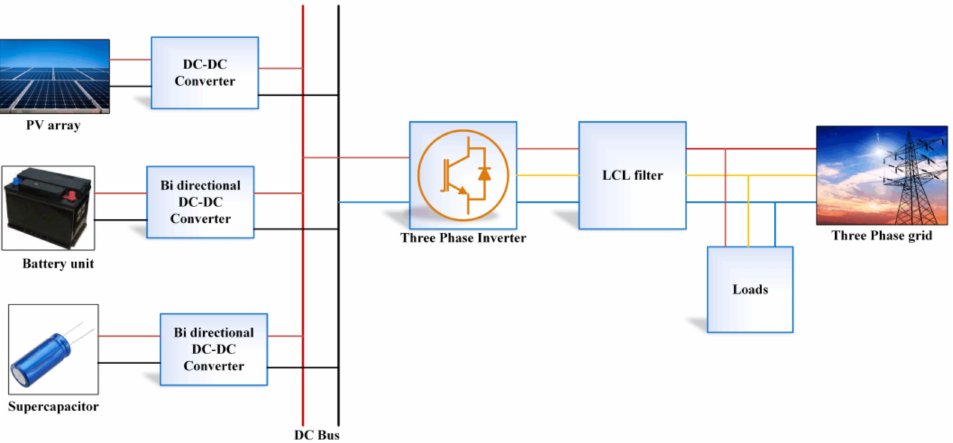
Figure 1. Grid-connected PV-HESS structure.